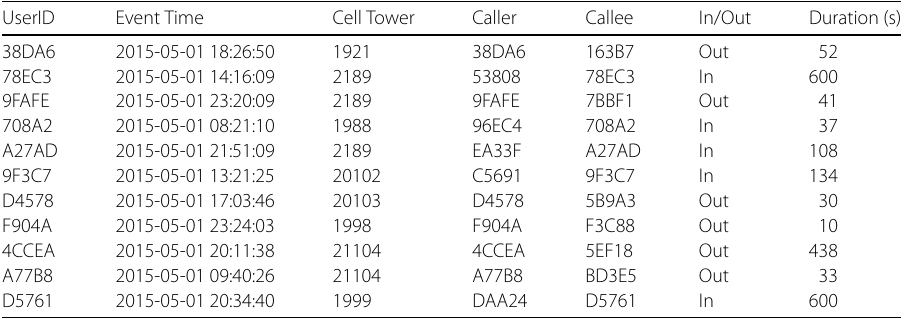
Table 1 The sample of CDR dataset. In this case, each CDR entry describes a voice call. All user identifiers and cell tower ids are coded to hide personal information. The GPS location of the cell towers is provided in the data